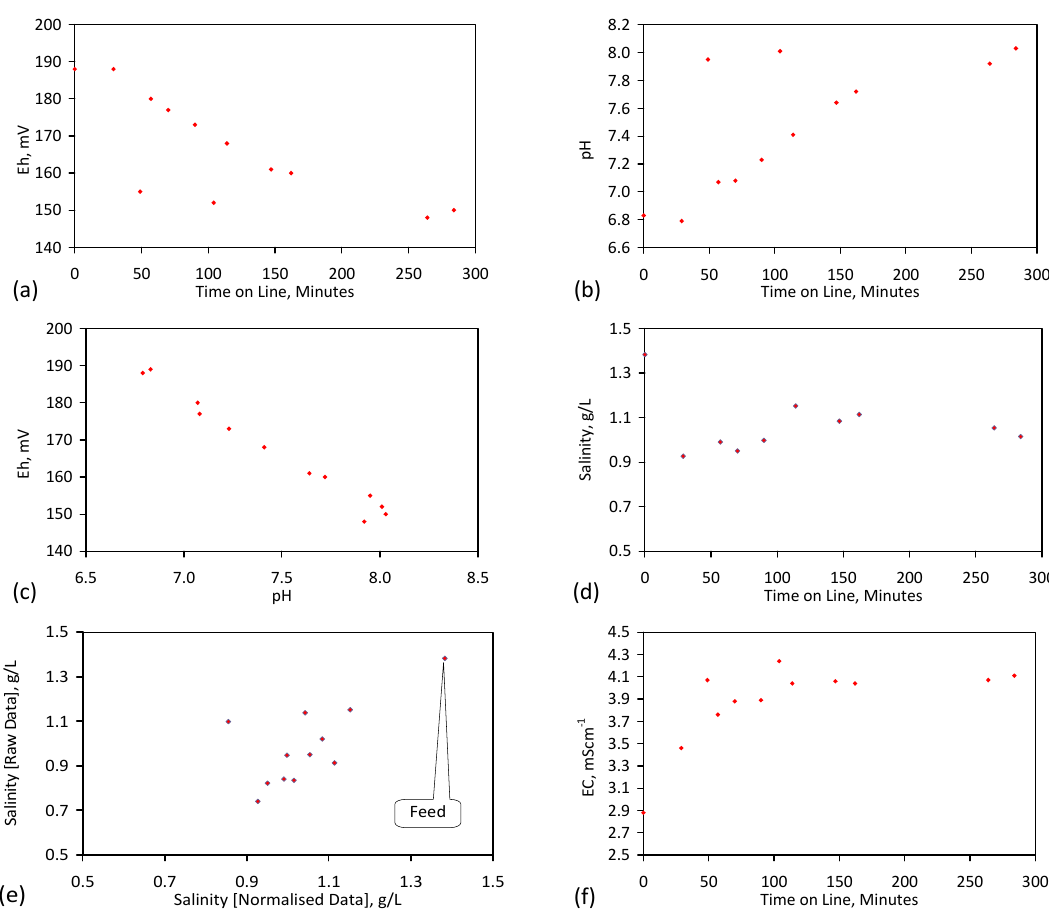
Figure C19. ZVM TPA Trial E145 Example. Initial Batch Run; Operating Temperature: 13–17 °C; Oxidising Environment: Water volume in the reactor = 0.114 m 3 ; ZVM TP in a cartridge = 1.449 kg; Air flow = 120 L·h − 1 . ( a ) Eh vs. time; ( b ) pH vs. time; ( c ) pH vs. Eh; ( d ) Salinity vs. time; ( e ) Salinity calculated from normalised data vs. salinity calculated from raw data; ( f ) EC vs. time.